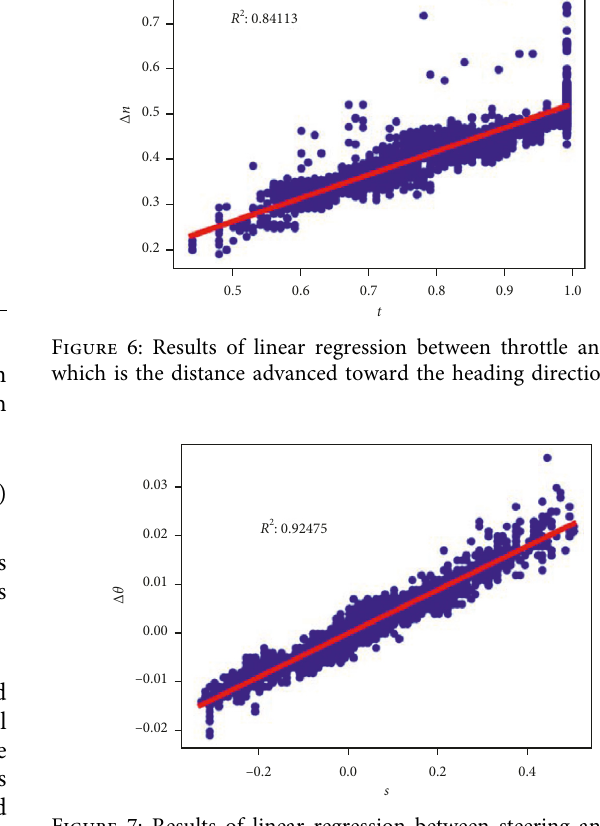
Figure 7: Results of linear regression between steering and ∆ θ , which is the change of heading